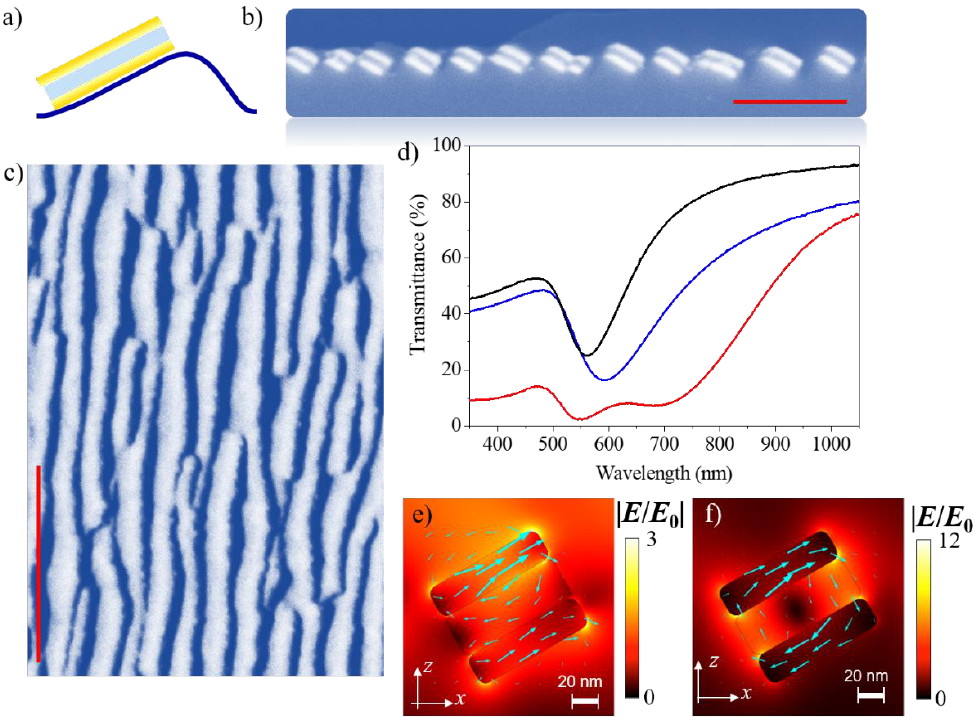
Figure 3. ( a ) Cross-section sketch of the Au-SiO 2 -Au nanostripe dimers; ( b , c ) cross-section and top-view SEM image of the nanostripe dimer arrays, respectively. The scale bars correspond to 500 nm and 1 µm, respectively; ( d ) extinction optical spectra for the TM-polarized excitation of Au nanostripe (black curve), Au-silica (blue curve) and Au-silica-Au nanostripe dimer arrays (red curve). The nanostripes’ width was fixed at about 105 nm, while the local thickness of the Au-silica-Au layers was set at 30-44-30 nm respectively; and ( e , f ) FEM simulation of the near field distribution for nanostripe dimer excited in resonance with the plasmonic electric- and magnetic-dipole mode (550 nm and 700 nm wavelength), respectively.